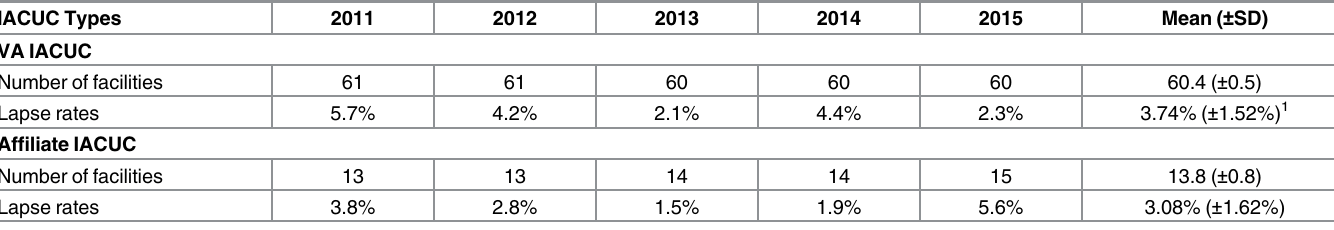
Table 2. Lapse in continuing reviews according to types of institutional animal care and use committee used. IACUC